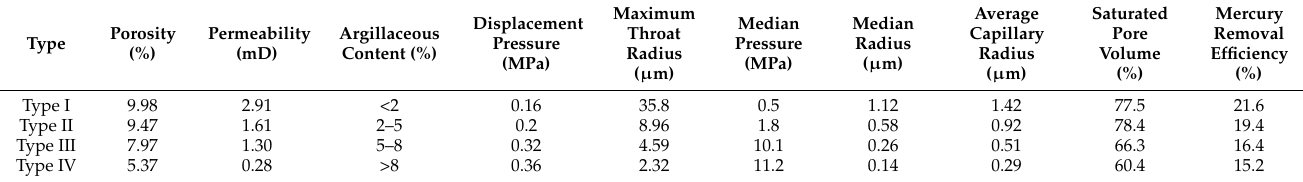
Table 1. Comparison of the micropore throat structure parameters of different reservoir